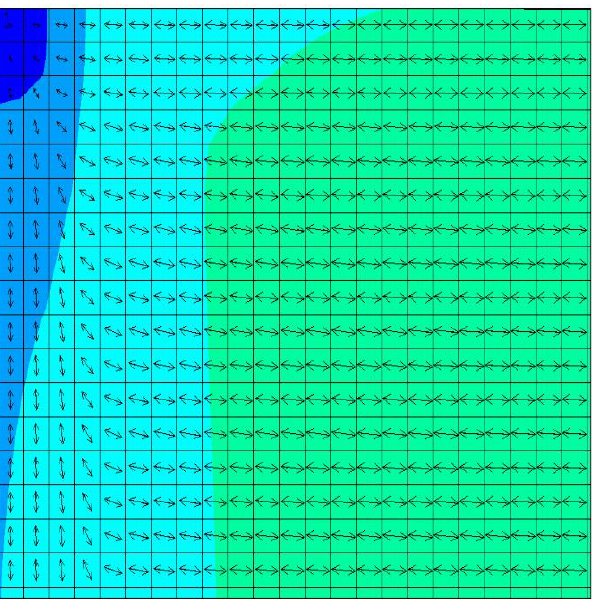
Figure 5. First principal stress direction of the film when the loading ratio was y : x = 1.5.